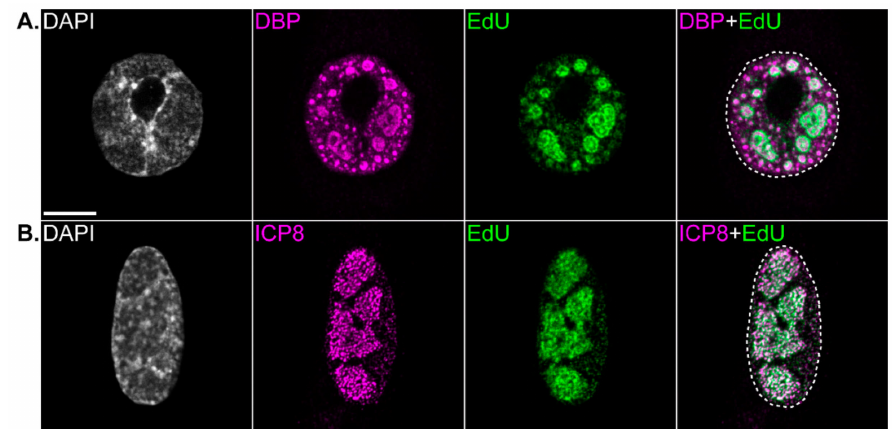
Figure 1. Viral replication compartments are the sites of viral genome replication. Immunofluorescence confocal microscope images showing viral replication compartments in a human adenovirus infected bronchial epithelial cell ( A ), or herpes simplex virus 1-infected foreskin fibroblast ( B ). The nucleus is visualized by the staining of DNA with DAPI. Viral replication compartments are visualized by the immunostaining of viral single-stranded DNA (ssDNA)-binding proteins DNA binding protein (DBP) or infected-cell protein 8 (ICP8), respectively. The sites of viral DNA replication are visualized by incorporating 5-Ethynyl-2’-deoxyuridine (EdU) into DNA during replication (15 min pulse, 10 µ M), and subsequently conjugating fluorophores to EdU in a copper-catalyzed cycloaddition reaction. The outline of the nucleus is shown (dotted line). Scale bar = 10 µ